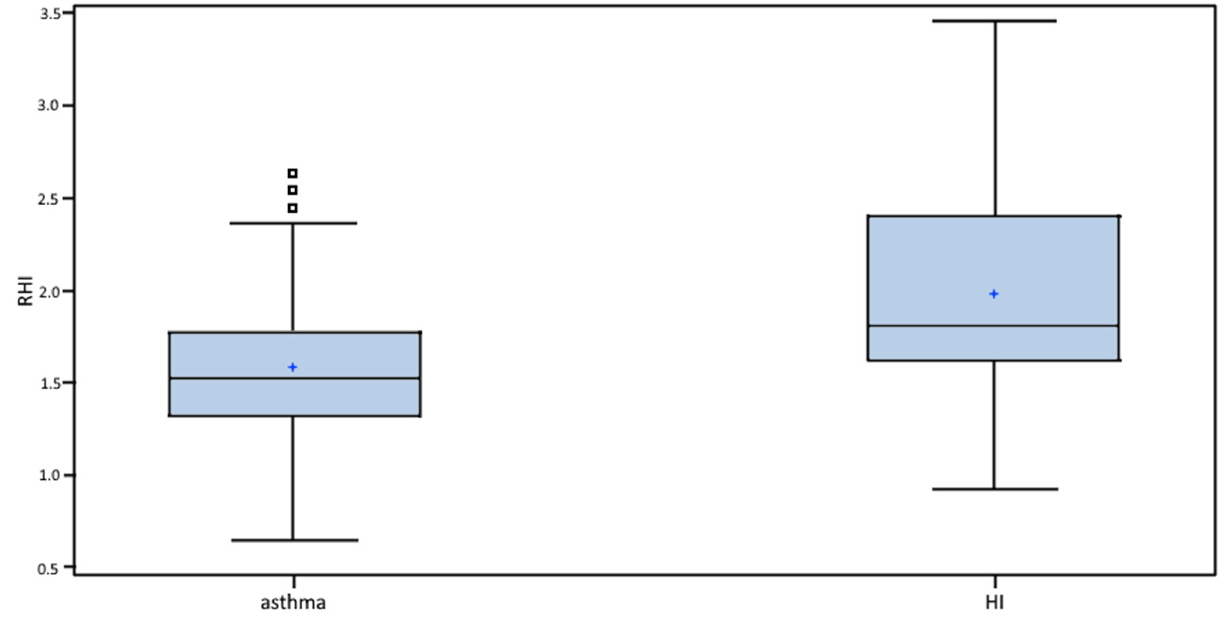
Figure 2. RHI in asthmatics vs. HI. Boxes indicate the inter-quartile range. Horizontal lines within boxes indicate medians. Whiskers extend to the highest or lowest values. RHI: reactive hyperemic index; HI: healthy individuals.